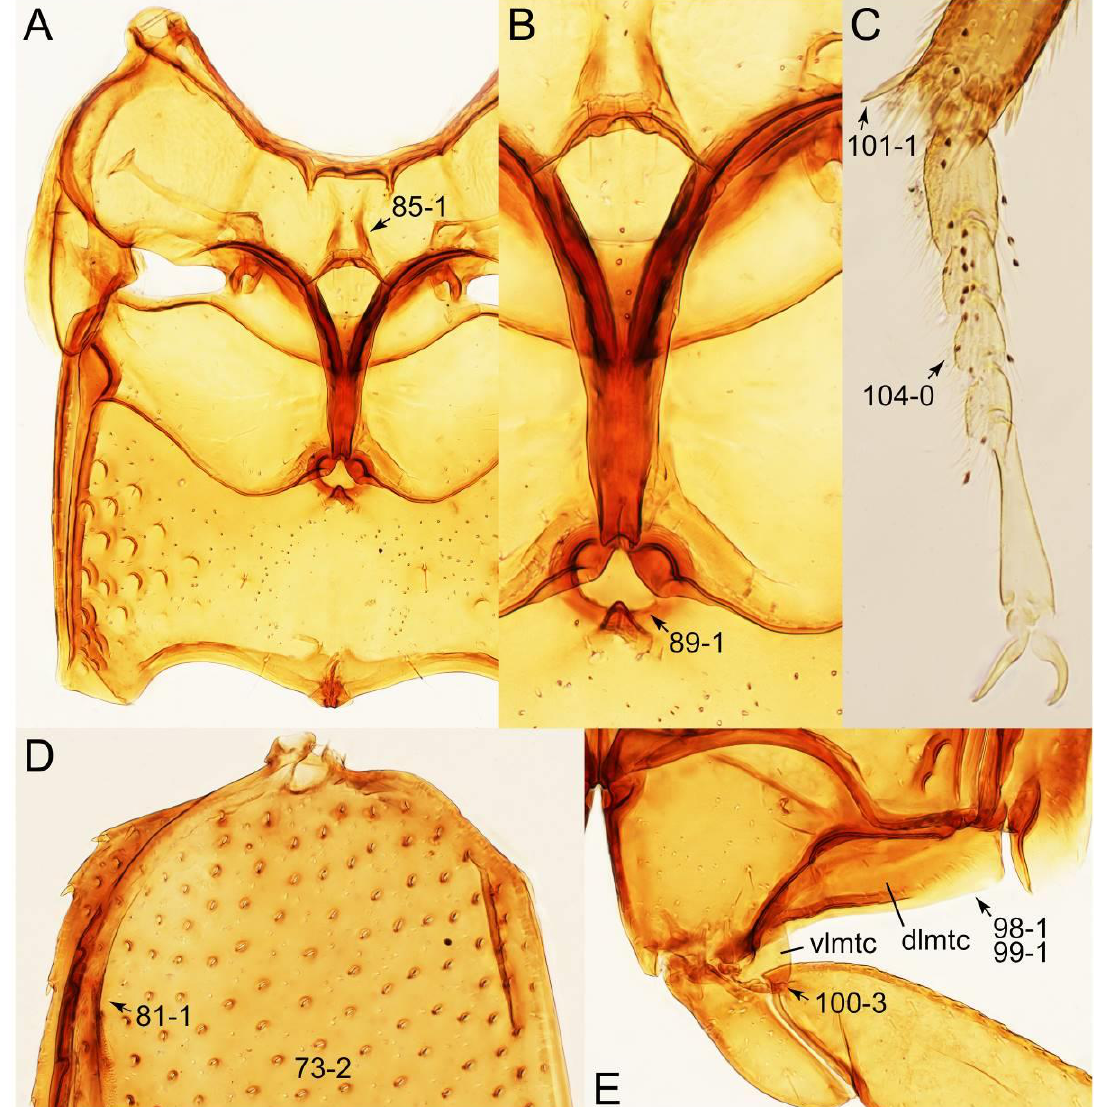
Figure 60. Photographs of body parts of Tachinusini: members of the former Megarthropsini, enlarged. ( A ) mesothorax and metathorax of Lacvietina takashii , ventral view. ( B ) intermesocoxal processes of Lacvietina takashii , ventral view. ( C ) right metatarsus and metatibial spines of Lacvietina takashii , dorsolateral view. ( D ) left elytron of Lacvietina takashii , dorsal view. ( E ) left metacoxa of Lacvietina takashii , ventral view. Abbreviations: dlmtc, dorsal lamella of metacoxa; vlmtc, ventral lamella of metacoxa. Characters and character states (format X-X) are indicated on each